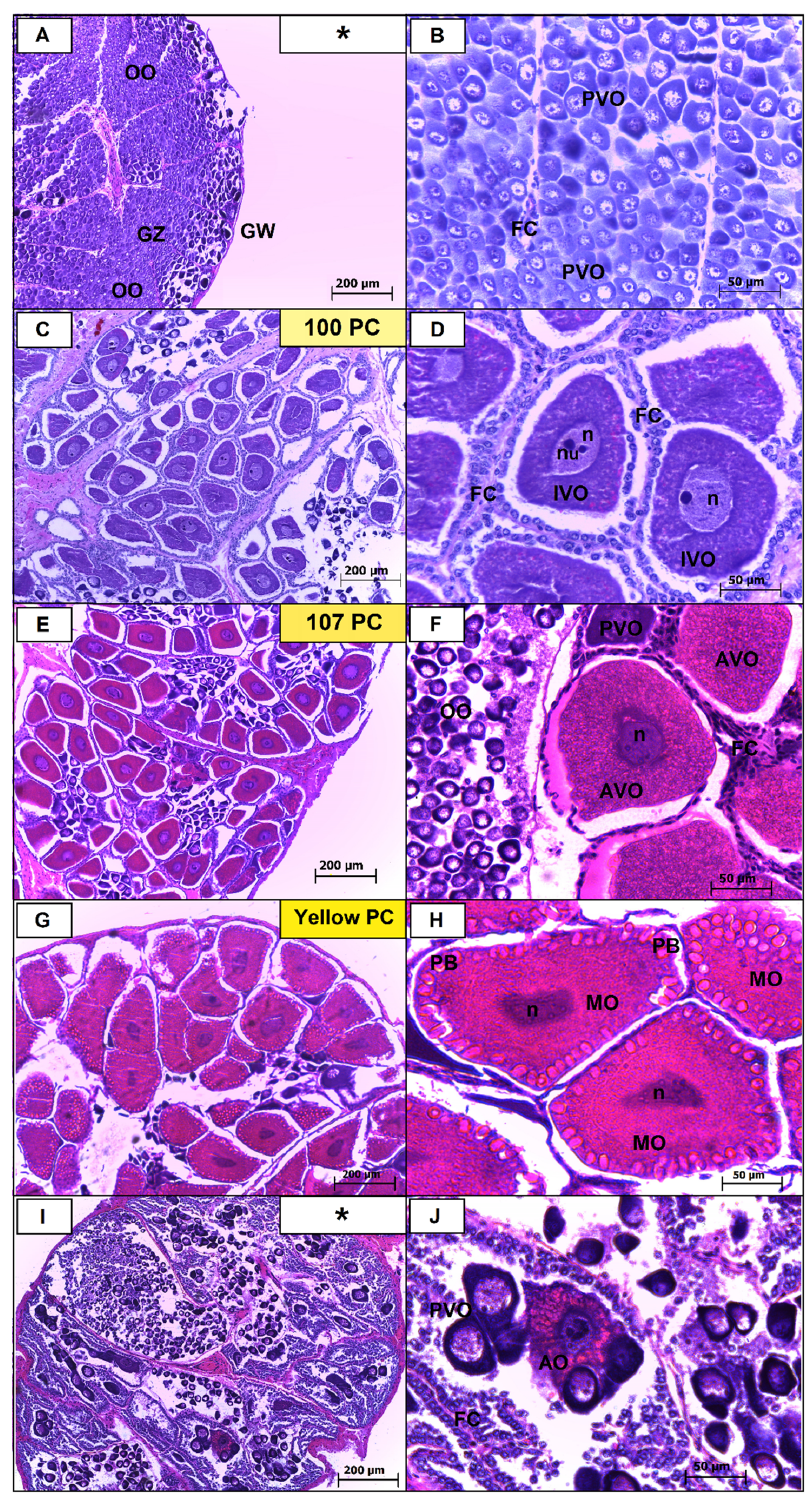
Figure 1. Photomicrographs of ovarian maturation of P. schmitti. ( A , B ) immature stage, ( C , D ) initial maturation stage, ( E , F ) advanced maturation stage, ( G , H ) mature stage, ( I , J ) spawned stage. OO: oogonia; PVO: previtellogenic oocytes; IVO: initial vitellogenic oocyte; AVO: advanced vitellogenic oocyte; MO: mature oocyte; AO: atretic oocyte; n: nucleus; nu: nucleolus; PB: peripheral bodies; FC: follicular cells; GZ: germinative zone; GW: gonadal wall. * Translucent